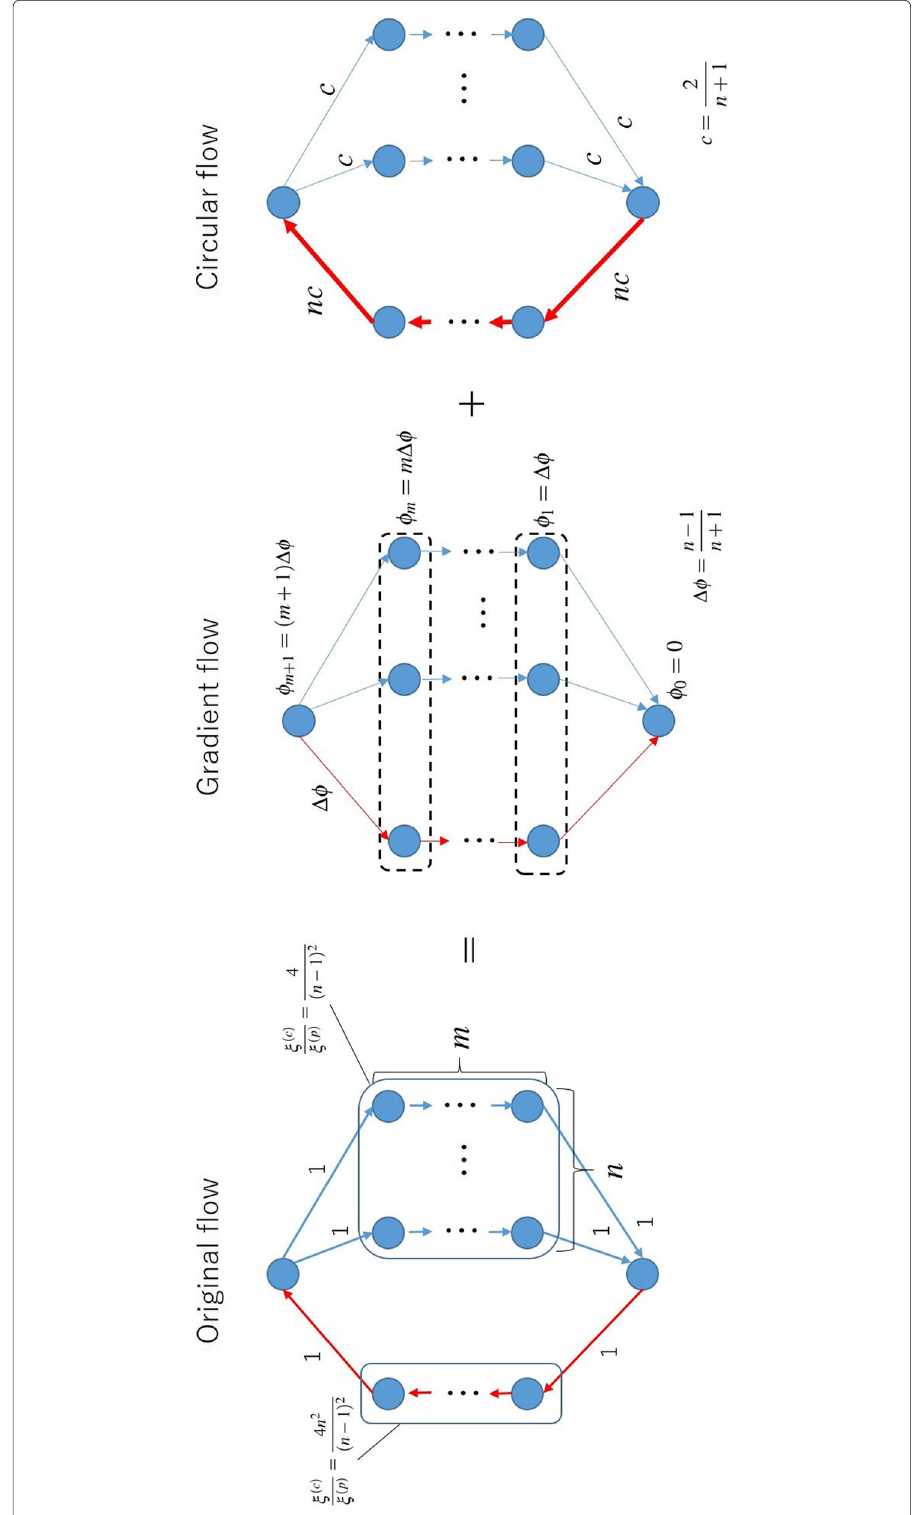
Fig. 15 A representative model network with feedback structure for the major communities in the transaction network and its Helmholtz-Hodge